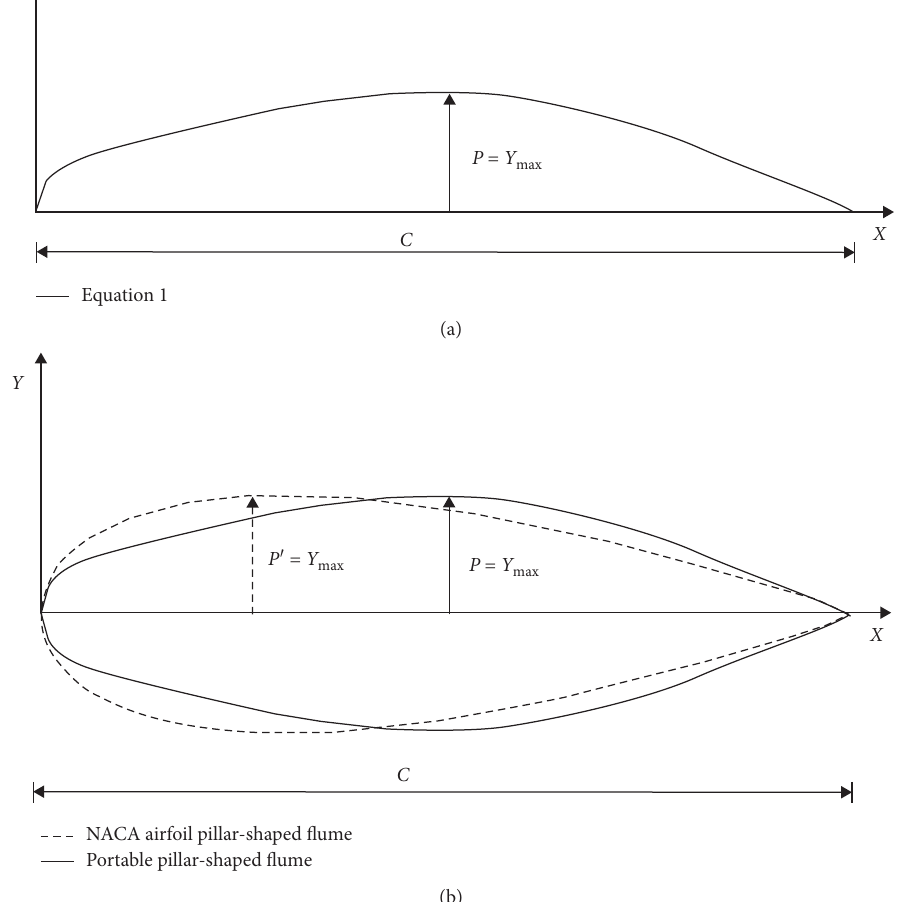
Figure 1: (a) The curve of optimized NACA airfoil equation; (b) the shapes of the NACA airfoil-shaped flume and portable pillar-shaped flume.